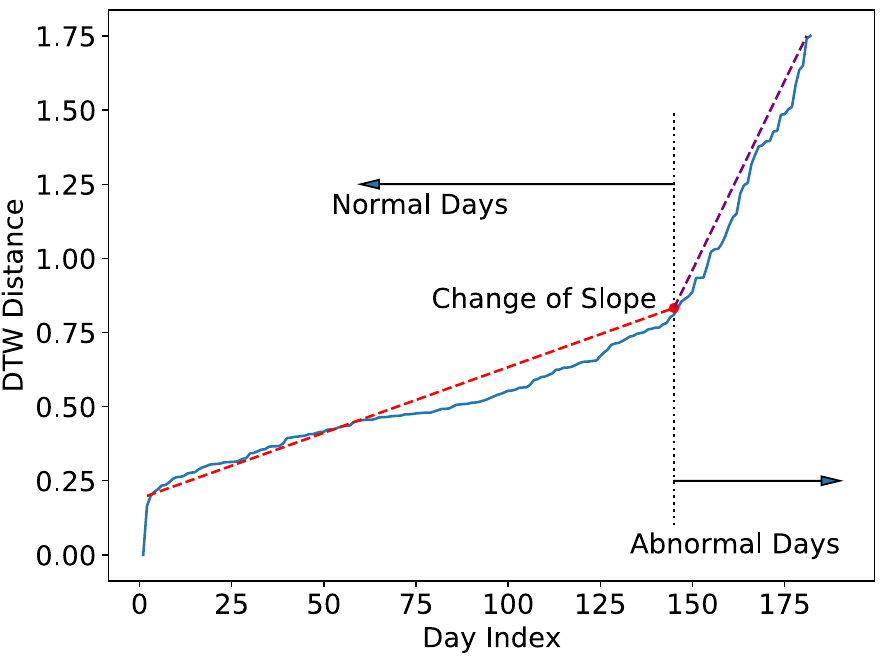
Figure 2. Summer season distances to reference normal day and normal/abnormal classification. Raw data (blue), fitted data for normal days (red), fitted data for abnormal days (purple).